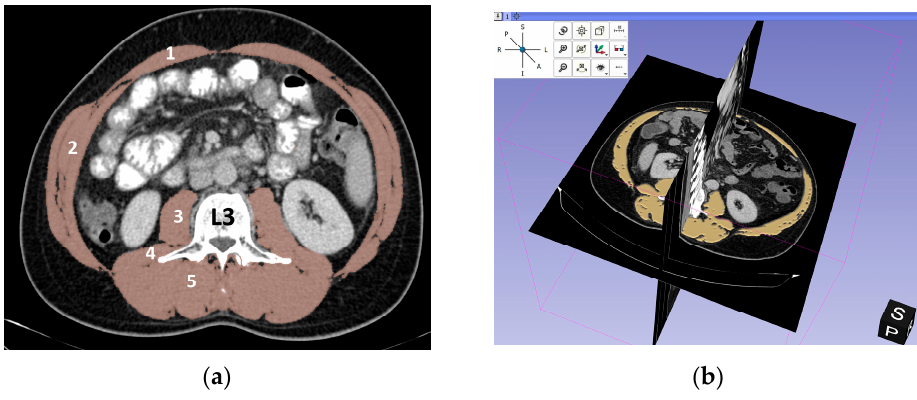
Figure 1. Axial cross-section at third lumbar vertebra (L3): ( a ) Total muscle area included: (1) rec- tus abdominis, (2) transversus abdominis, internal and external oblique, (3) psoas, (4)